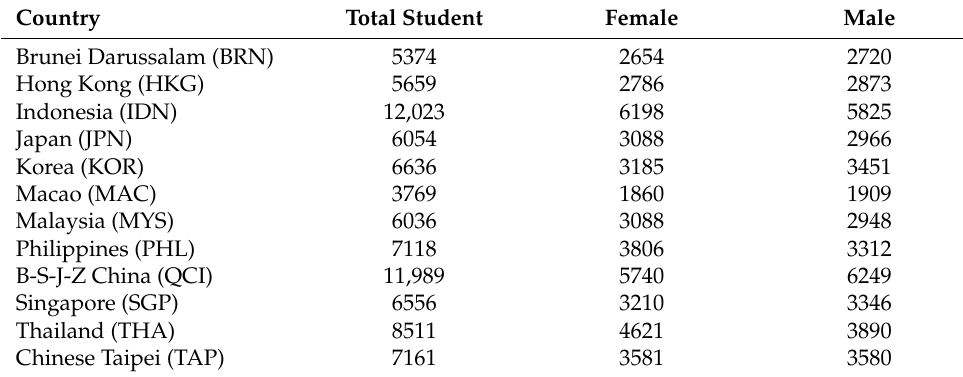
Table 1. PISA data